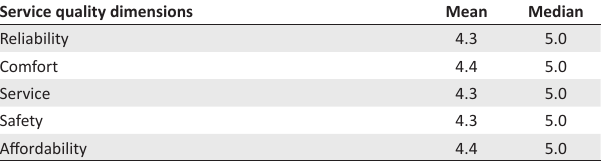
TABLE 3: Importance of service quality